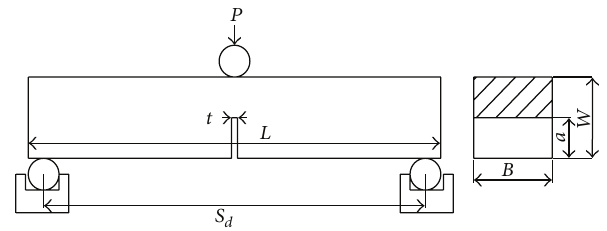
Figure 1: Loading sketch of the three-point bending